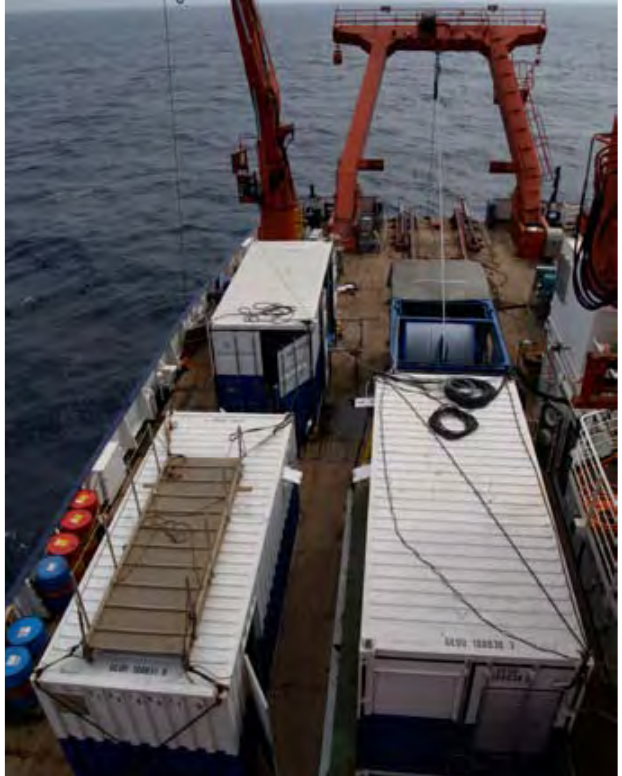
Figure 3. View of the work deck of RV Meteor during a deployment of the